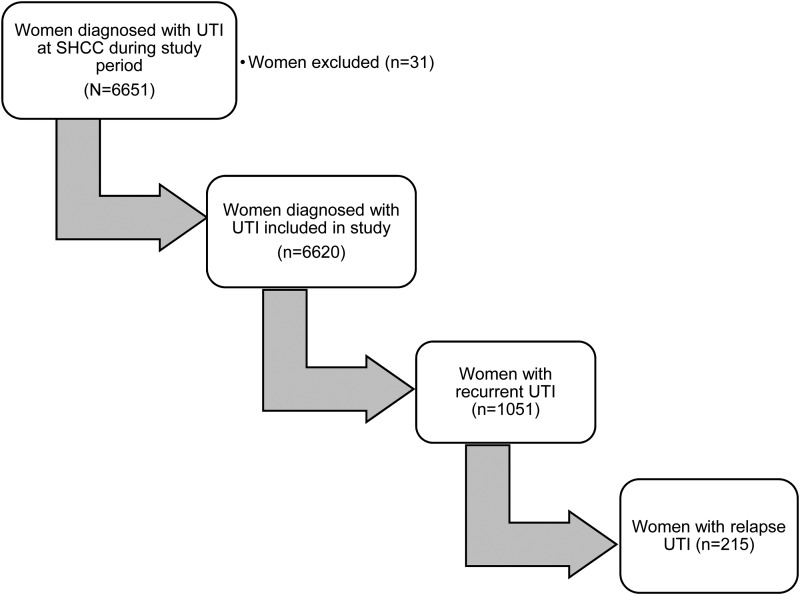
Study population.